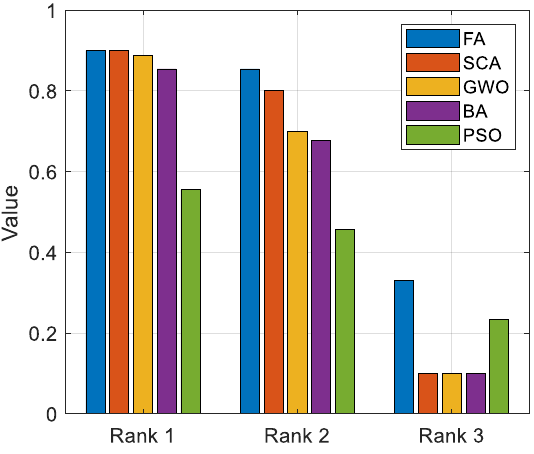
Figure 18. Controllers ranking indexes.